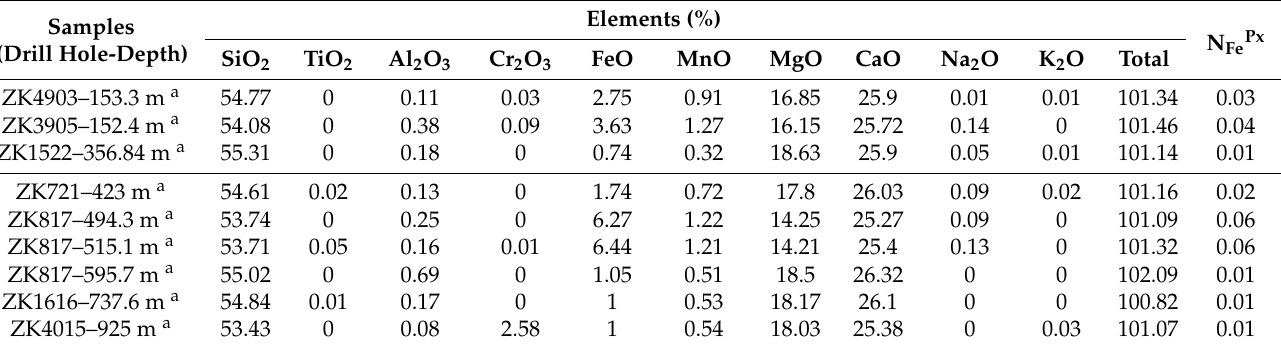
Table 5. EPMA analysis results (wt. %) and N FePx of pyroxene.